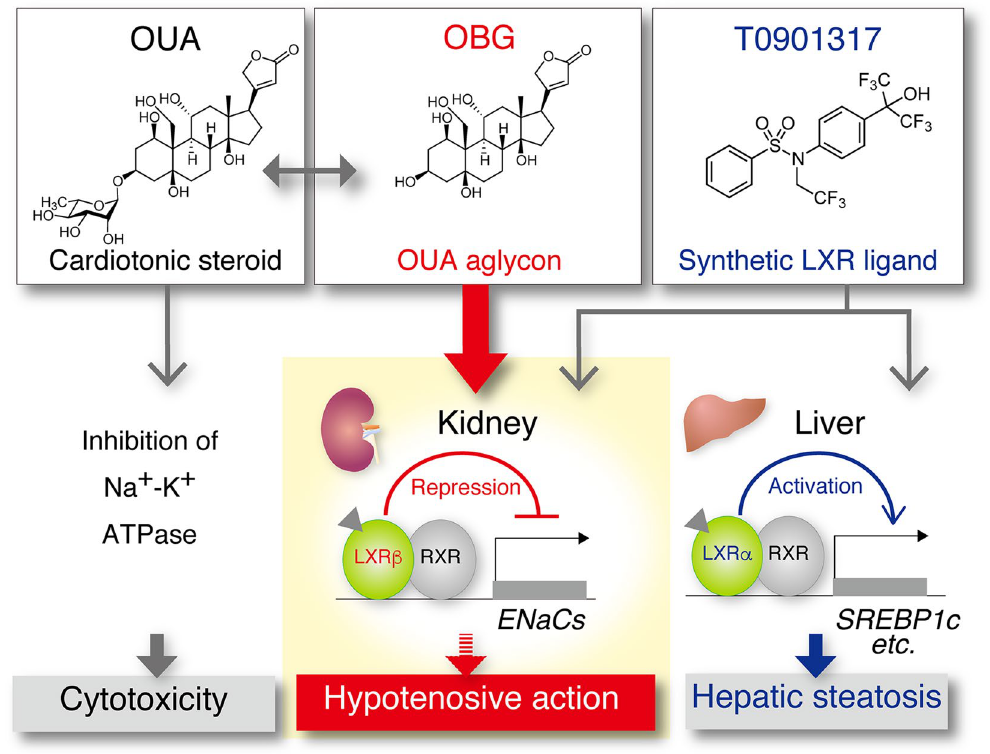
Figure 7. Schematic diagram depicting OBG’s suppressive effect on expression of ENaCs in kidney. OBG, a aglycone of OUA, functions as a LXR β agonist to down-regulate ENaC in kidney both in vitro and in vivo where as OUA shows cardiotonic action and cytotoxicity. Notably, OBG doesn’t cause hepatic steatosis which is severe side effect induced by conventional LXR ligands. Thus, OBG is a novel class of LXR ligand as a promising antihypertensive